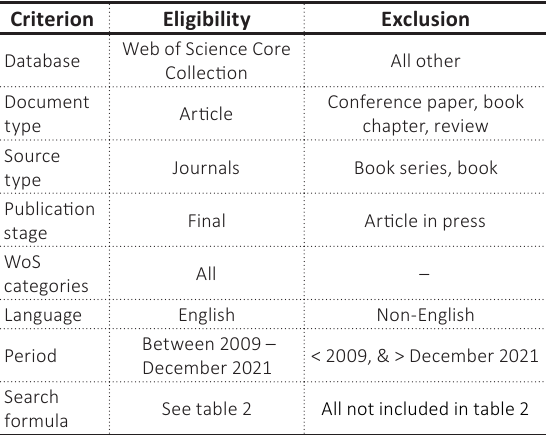
Table 1. Inclusion and exclusion criteria of sample selection